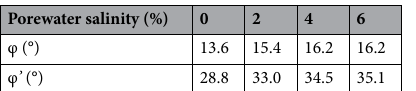
Table 4. The internal friction angles of soil with different salinities.